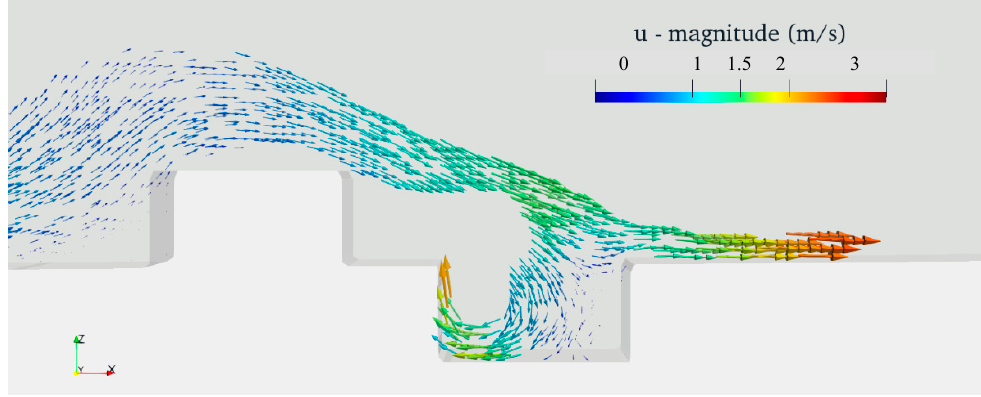
Figure 26. Current velocity vectors at t = 13.2 s for simulation Case 36 (Table 4).